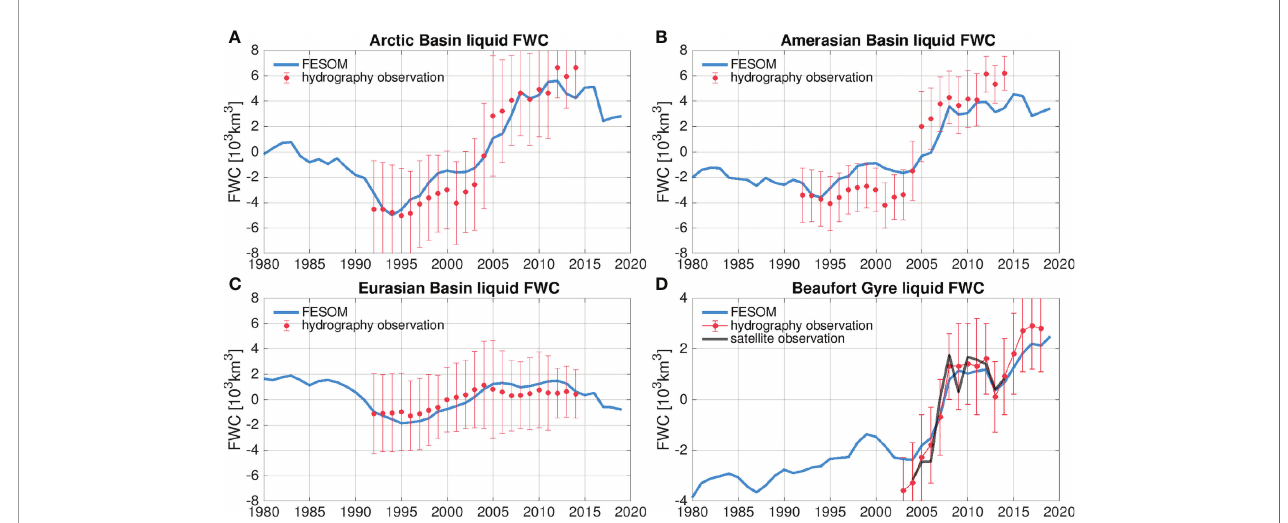
FIGURE 7 | Observed and simulated liquid freshwater content (FWC, 10 3 km 3 ) anomalies in the Arctic Ocean. FWC anomaly in the (A) Arctic deep basin [sum of Amerasian Basin (AB) and Eurasian Basin (EB)], (B) AB, (C) EB, and (D) Beaufort Gyre region in the FESOM historical simulation and observations (Rabe et al., 2014; Proshutinsky et al., 2019). Hydrography-observation uncertainties are indicated with error bars. In (A – C) a reference salinity of 35 was used in the observational estimates (Rabe et al., 2014). This different reference salinity in fl uences the absolute value of FWC, but has minor impacts on the FWC anomaly (not shown).